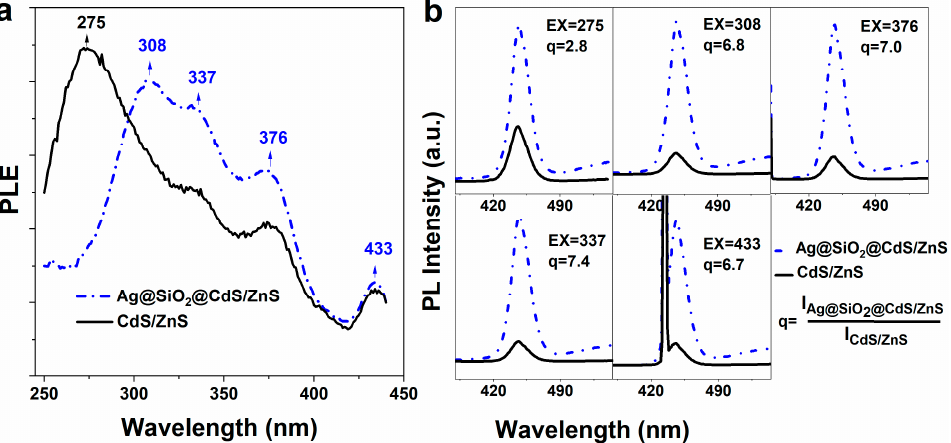
Figure 4. ( a ) Photoexcitation spectra of CdS/ZnS QD (black solid line) and Ag@SiO 2 (12 nm)@CdS/ZnS QD composite nanoparticles (blue short dash dot line), respectively; ( b ) Fluorescence spectra of CdS/ZnS QD (black solid line) and Ag@SiO 2 (12 nm)@CdS/ZnS QD composite nanoparti- cles measured under different energy excitation conditions, respectively, where EX represents the excitation light wavelength and q represents the ratio of the intrinsic fluorescence peak area (with an integrated wavelength range of 420-480 nm) of CdS/ZnS QD (black solid line) and Ag@SiO 2 (12 nm)@CdS/ZnS QD composite nanoparticles (blue short dash dot line).